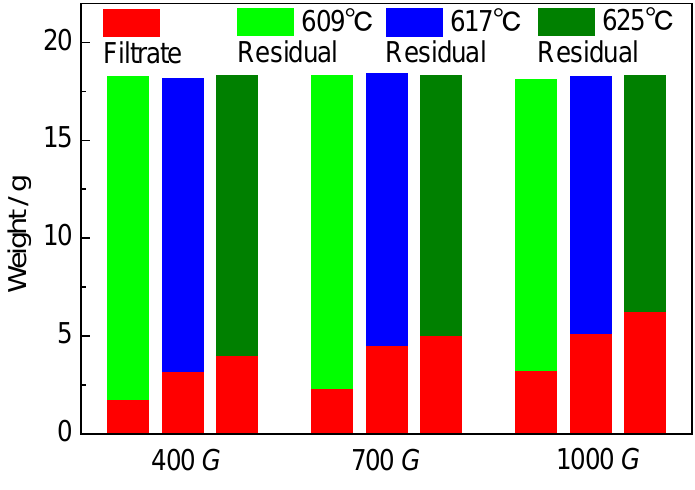
Figure 2. The weights of filtrate and residual in the trials 1–9.